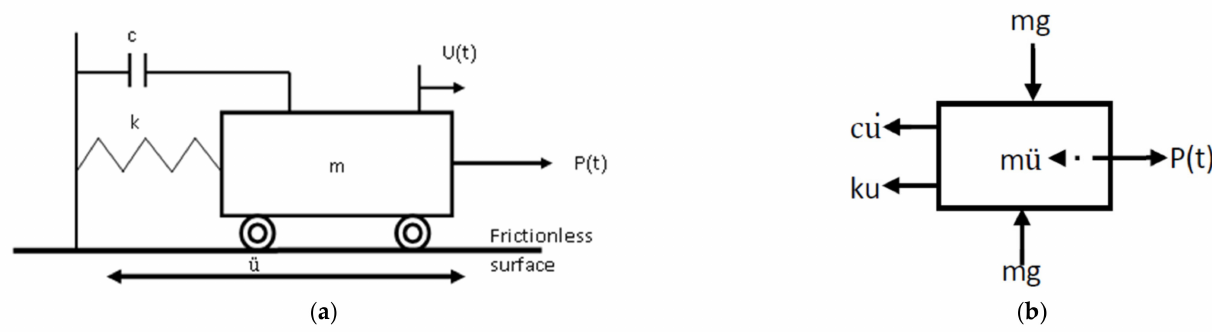
Figure 4. Mechanics of typical SDOF motion for earthquake ground motion modeled on [11]. ( a ) The typical mass–spring–damper (MSD) model. ( b ) The free-body diagram (FBD) of the shaker